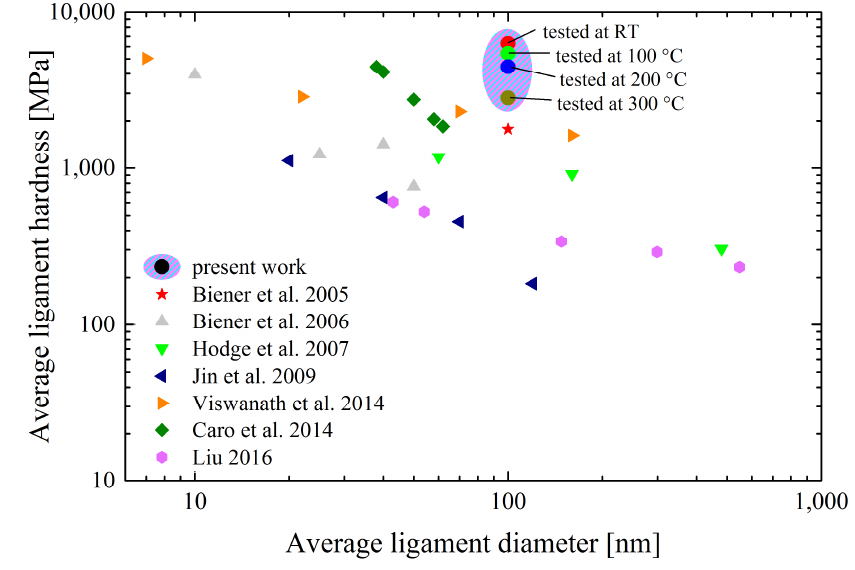
Figure 6. Comparison of literature ligament hardness values of NP Au foams with the present material in dependence of the ligament diameter [2,4,14,40,65–67].